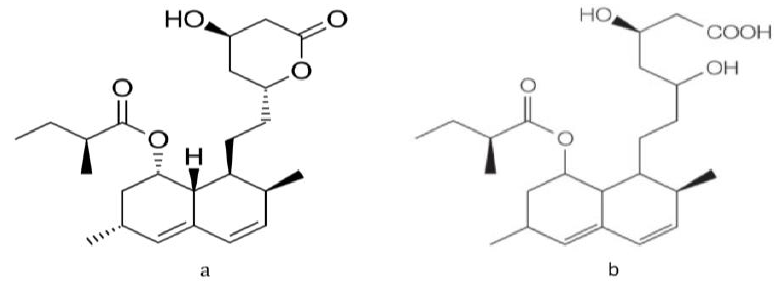
Figure 1. Structure of lovastatin. ( a ) Inactive lactone form ( b ) activated hydroxyl acid form.